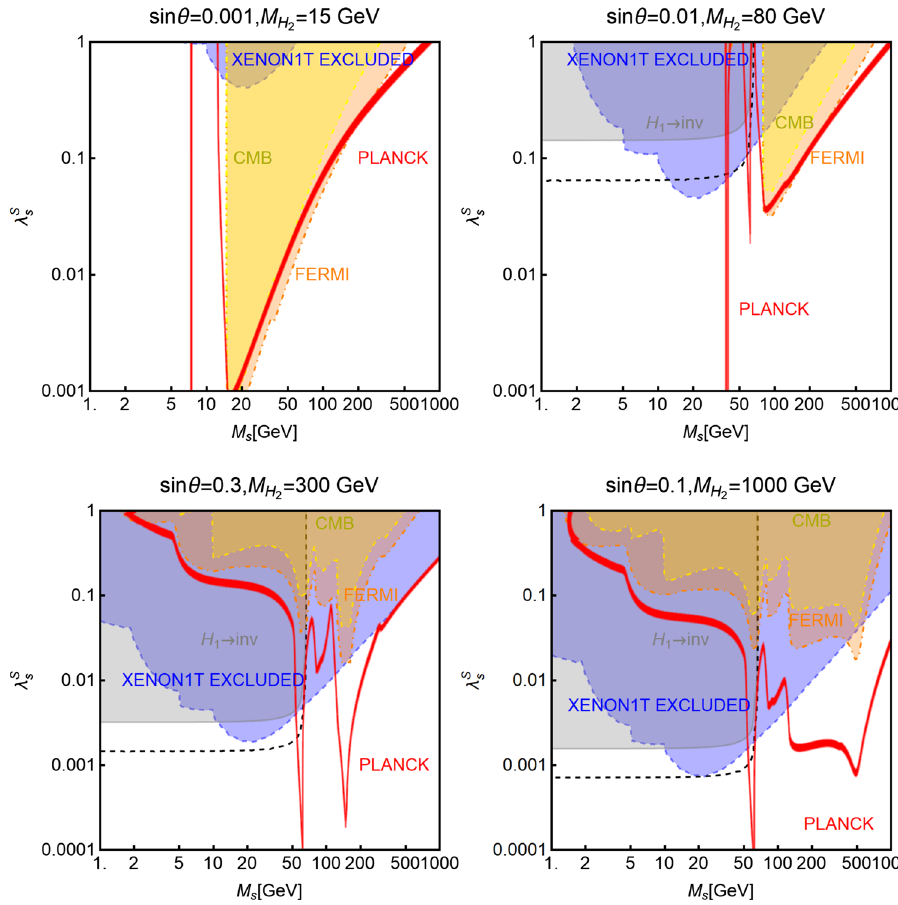
Fig. 6 Summary of constraints for a scalar DM particle s interacting with the SM through the mixing portal, in the [ M ,λ S ] plane, for specific s s values of (sin θ , M H ) of 2 ( 0 . 001 , 15GeV ) , ( 0 . 01 , 80GeV ) , ( 0 . 3 , 300GeV ) and ( 0 . 1 , 1000GeV ) . The red contours correspond to the correct relic density, the blue region is excluded by constraints from DM direct detection (XENON1T) and the gray region corresponds to the bounds from the Higgs invisible branching